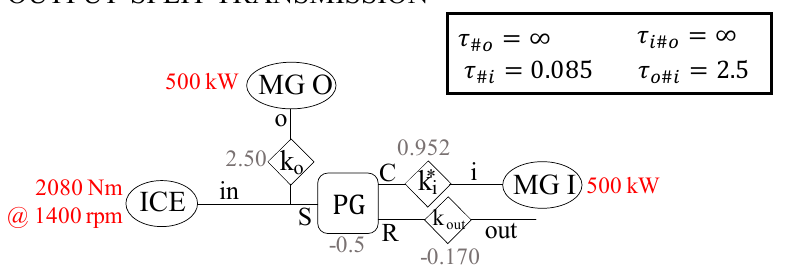
Figure 8. Functional layout of the output-split transmission designed for ICE working at 1400 rpm and 2080 Nm. The shown OGs arrangement corresponds to the first row of Table 6.